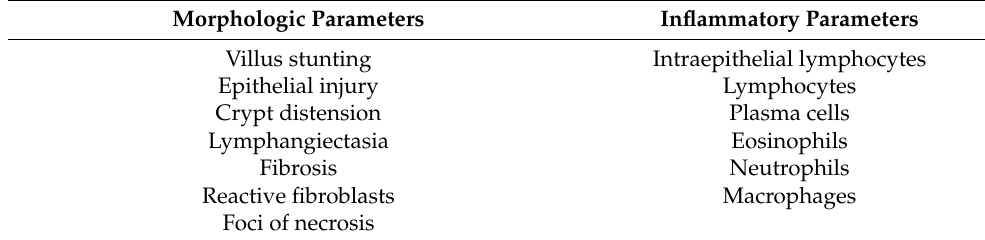
Table 2. Morphological and inflammatory parameters evaluated in the cases